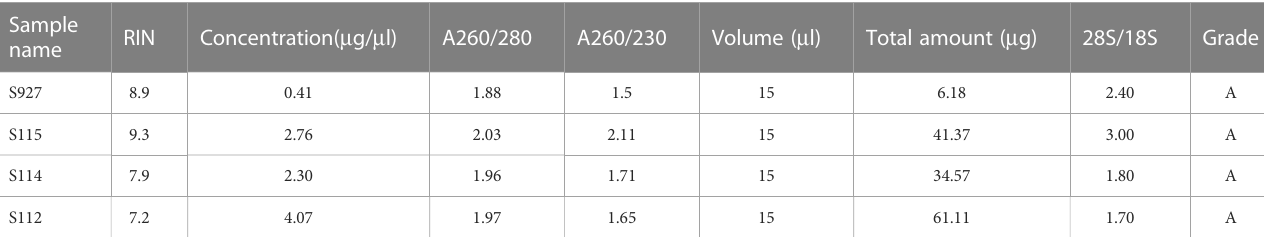
TABLE 1 The quality control of the samples.